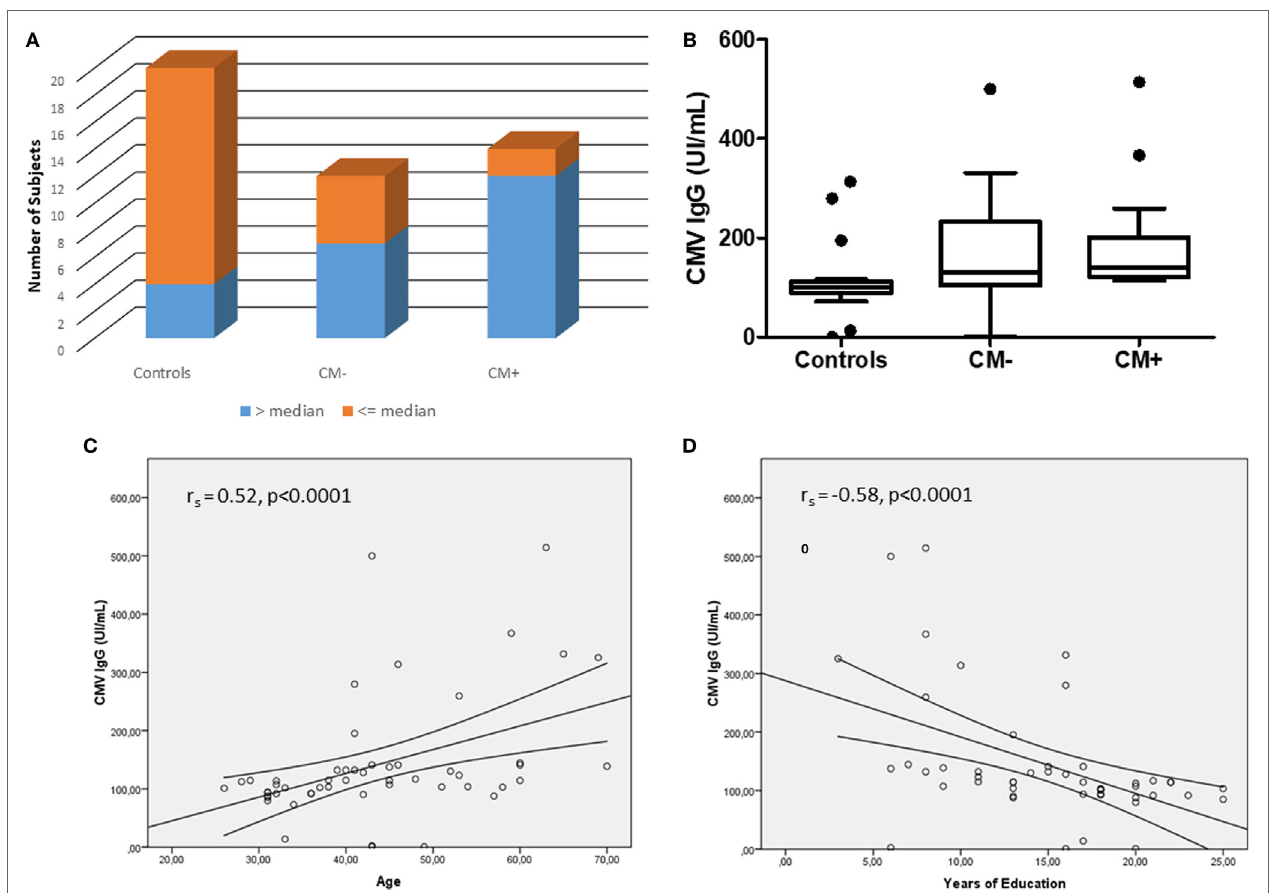
FigUre 3 | The cytomegalovirus (CMV) serology between studied groups. (a) Shows the number of subjects with IgG anti-CMV levels > or ≤ median (114.40). (B) Shows the CMV IgG levels between groups. After adjusting for age and years of education, no differences were observed between groups (Wald = 0.27, p = 0.87). (c,D) Show the correlations between CMV IgG serology and age and education,